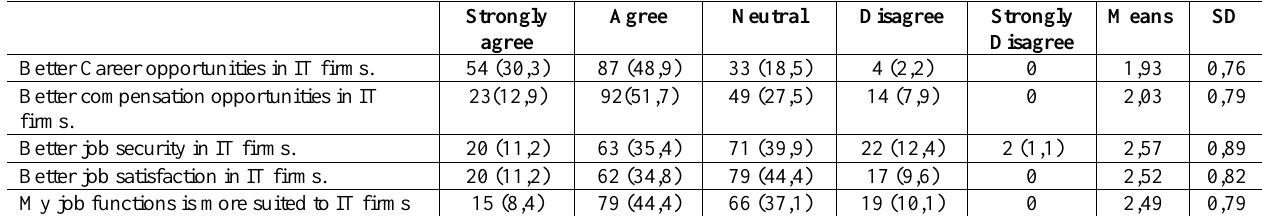
Table 4: Individual factors affecting outsourcing decision Better Career opportunities in IT firms. 54 (30,3) 87 (48,9) 33 (18,5) 4 (2,2) 0 1,93 0,76 Better compensation opportunities in IT firms. Better job security in IT firms. 20 (11,2) 0,89 Better job satisfaction in IT firms. My job functions is more suited to IT firms 15 (8,4) Table 5: Organizational factors affecting outsourcing decision My IS skills are enhanced at the onset of the outsourcing venture Helping me identify further career objectives Welfare of IS system professional key factor in management of contracting company Maintain positive attitude about success Communication flow since onset was adequate to keep positive attitude Outsourcing venture proved positive in advancing my career Table 6: Vendor company and factors affecting outsourcing decision Committed to success of customer 26 (14,6) Committed to success of employer Welfare of IS system professional key factor in outsourcing company Outsourcing venture proved positive in advancing my